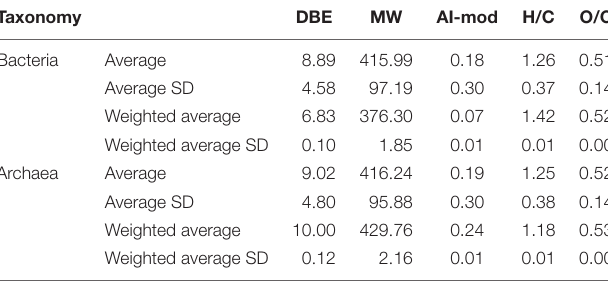
TABLE 1 | Average and weighted average of indices of DOM molecules significantly correlated (Pearson’s correlation with r ≥ 0.65, P < 0.01) to bacterial and archaeal